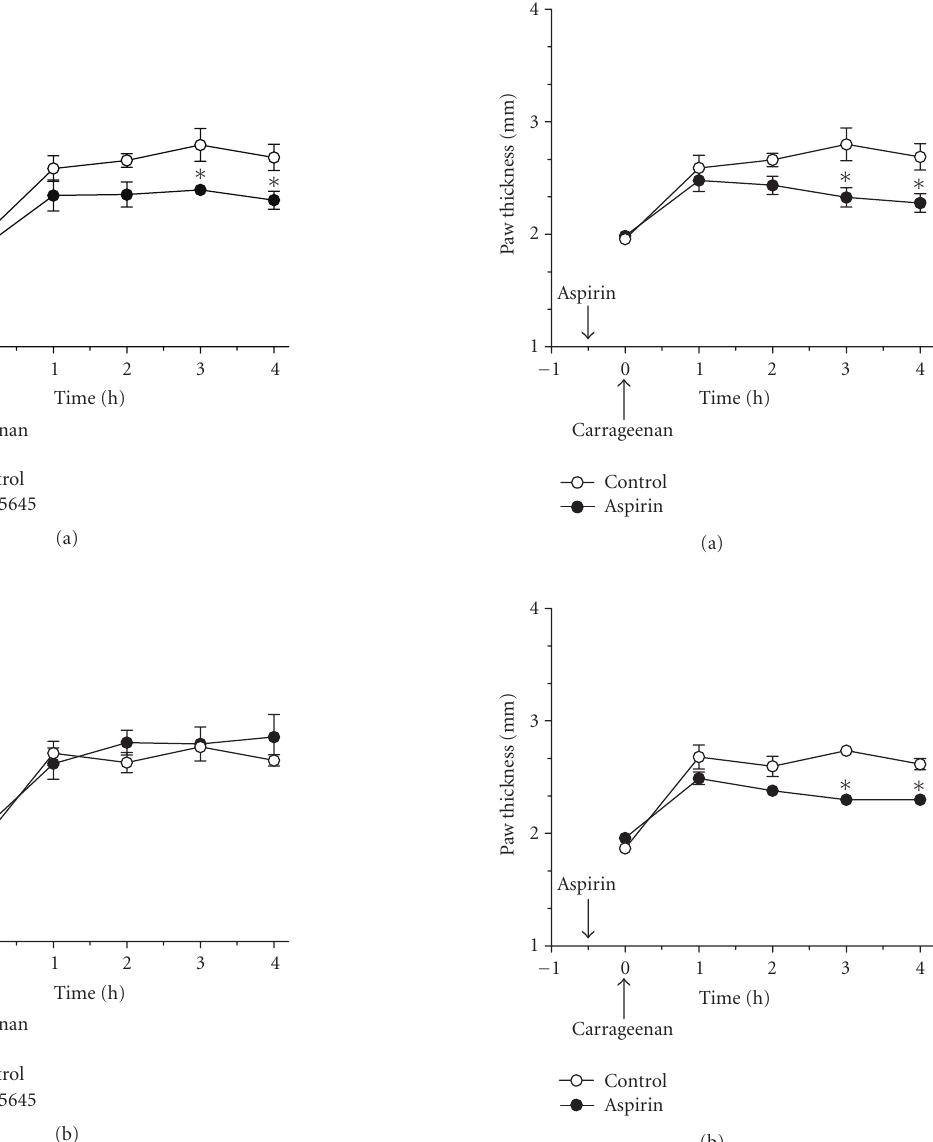
Figure 5: E ff ect of aspirin on carrageenan-induced paw edema in wild-type and hepatocyte-specific RXR α -deficient mice. Wild-type (a) and hepatocyte-specific RXR α -deficient mice (b) were treated in- traperitoneally with (50mg/kg) of aspirin, 30 minutes before induc- tion of inflammation. As indicated by the arrow, carrageenan (1%, intraplantar) was injected at t = 0. Carrageenan-induced edema is reflected by an increase in paw thickness. Values represent mean ± SEM. n = 3–5 mice per group. ∗ P < . 05 versus corresponding wild-type